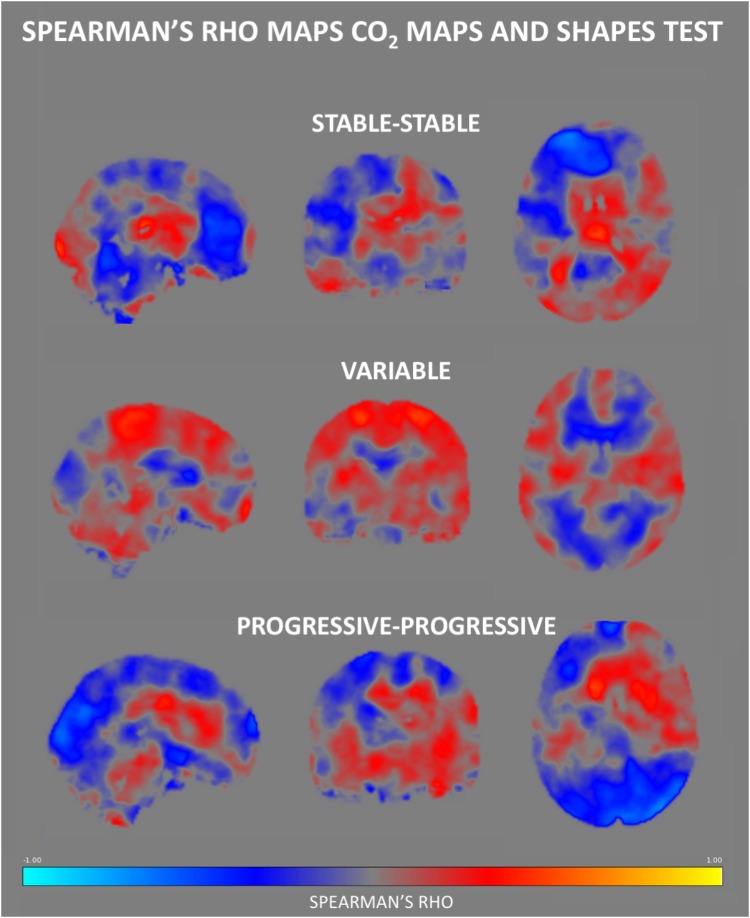
Regional Spearman’s rho correlation maps between CVR CO2 response and the Shapes test performance. Both the SS and PP groups displayed a fairly similar pattern of correlation, showing a positive relationship in the medial brain, with a frontal display of negative rho values. In contrast, the V group demonstrates negative correlations in medial brain regions, along with positive ones in parietal areas.